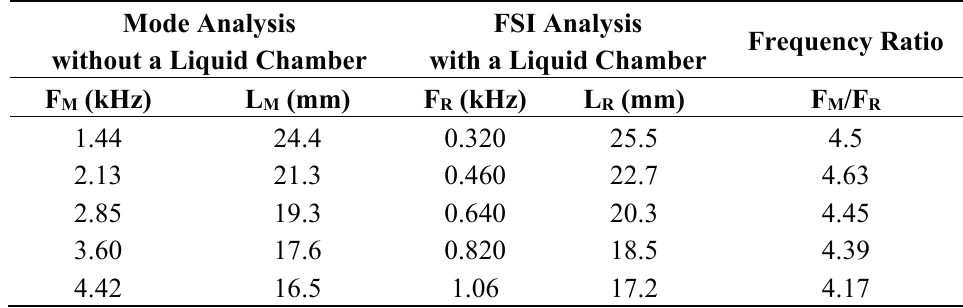
Table 1. FEA comparison between modal frequencies (F M ) and the position of MRD (L M ) at each F M of the membrane part without a liquid chamber and the local resonant frequencies (F R ) and position of MRD (L R ) at each F R of whole PAC with a liquid